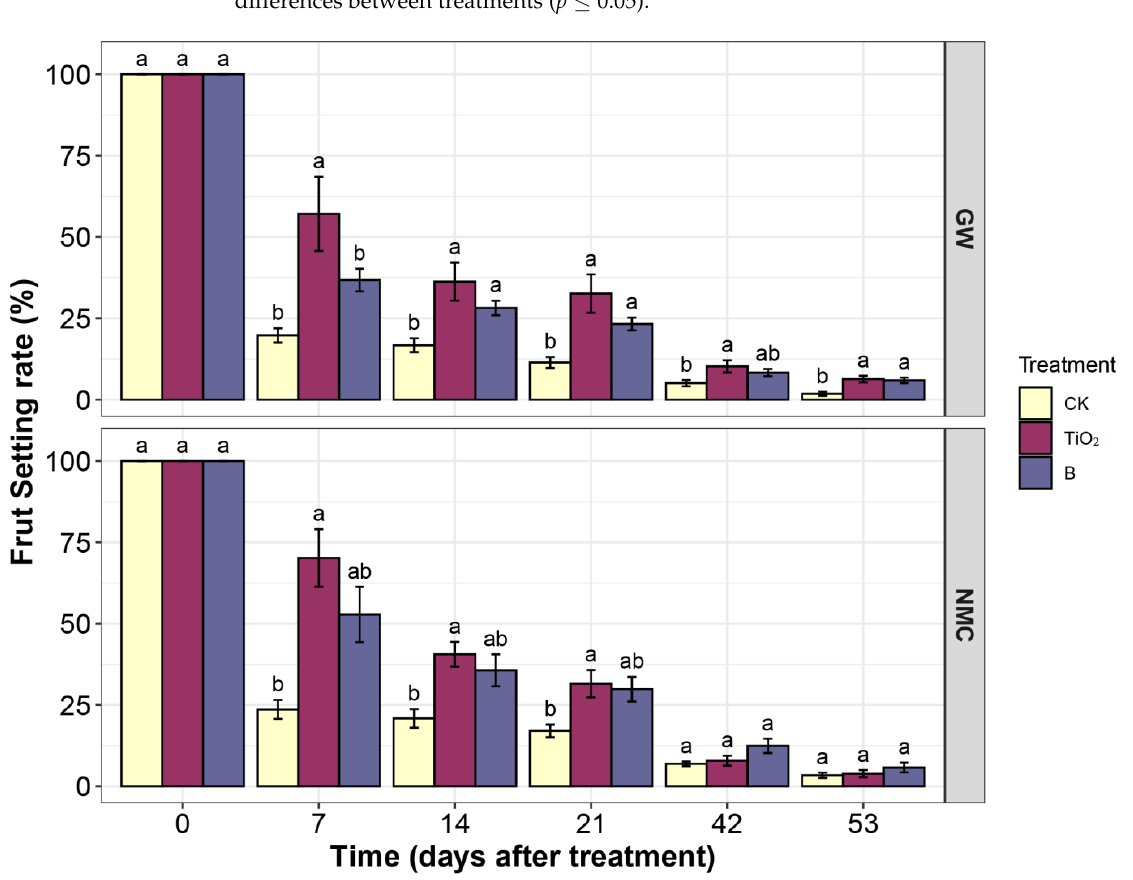
Figure 3. Fruit set influenced by nTiO 2 and boric acid in litchi. GW: litchi cultivar ‘Guiwei’; NMC: litchi cultivar ‘Nuomici’. B: Boric acid. Different letters indicate statistical differences between treatments ( p ≤ 0.05).